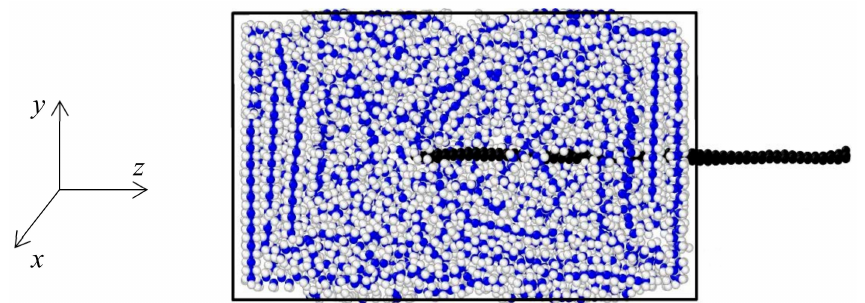
Figure 11. Pull-out mechanics of the graphene sheet (BN–C nanosheet with 100% carbon atoms) from the BN–C / PE nanocomposite at 300 K.